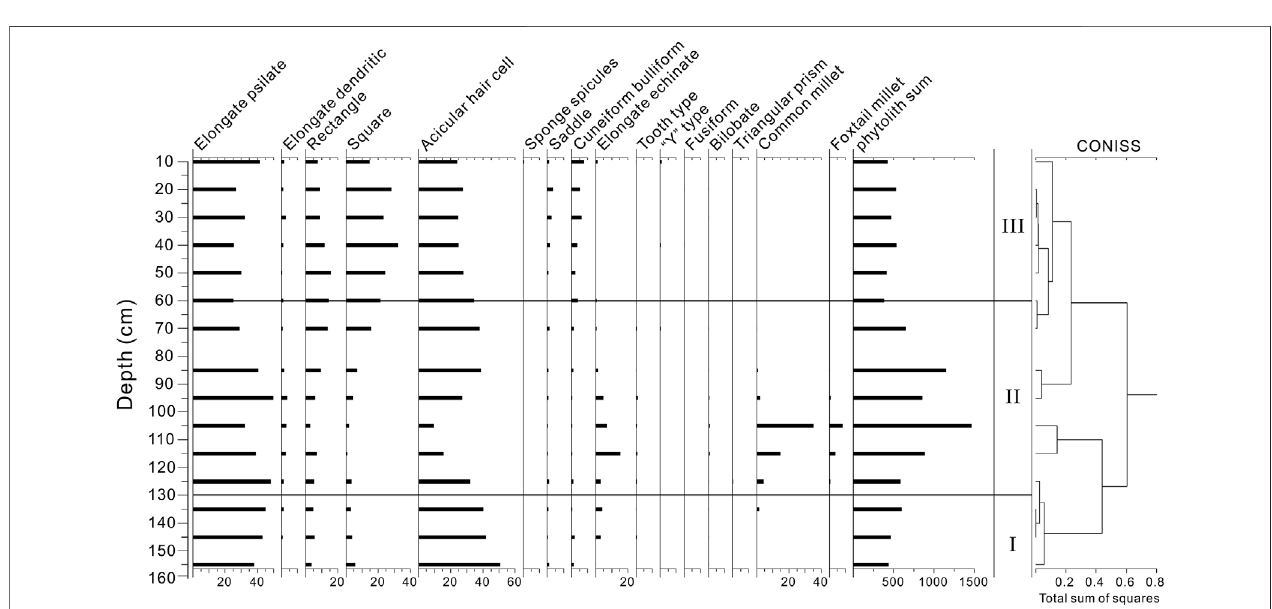
FIGURE 5 | Percentage diagram of the main phytolith types for the ZKG section.